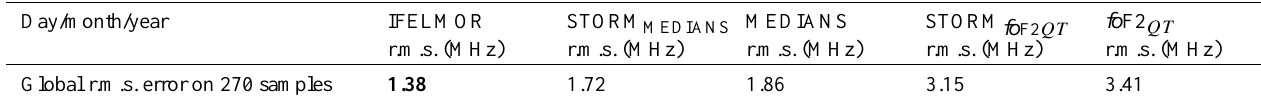
Table 2. Comparisons in terms of r.m.s. for all the days selected under disturbed ionospheric conditions; the best performance is labelled in bold.